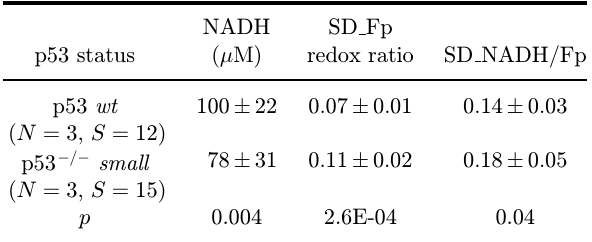
Table 2. Section univariate analysis results of size matched